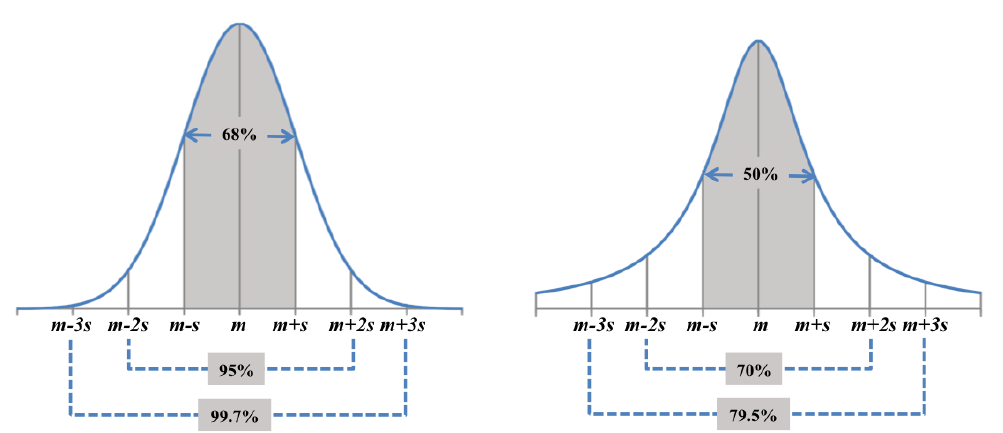
Figure 1. Universal empirical rules for all normal ( left ) and Cauchy ( right ) distributions. Here m represents the median, and s represents the distance (called standard deviation for normal distributions and scale parameter for Cauchy) from m to the inflection point. Although both families, normal and Cauchy, have similar bell-shaped density functions, normal distributions satisfy the main strong- domination and overrepresentation properties presented in this note, but Cauchy distributions do